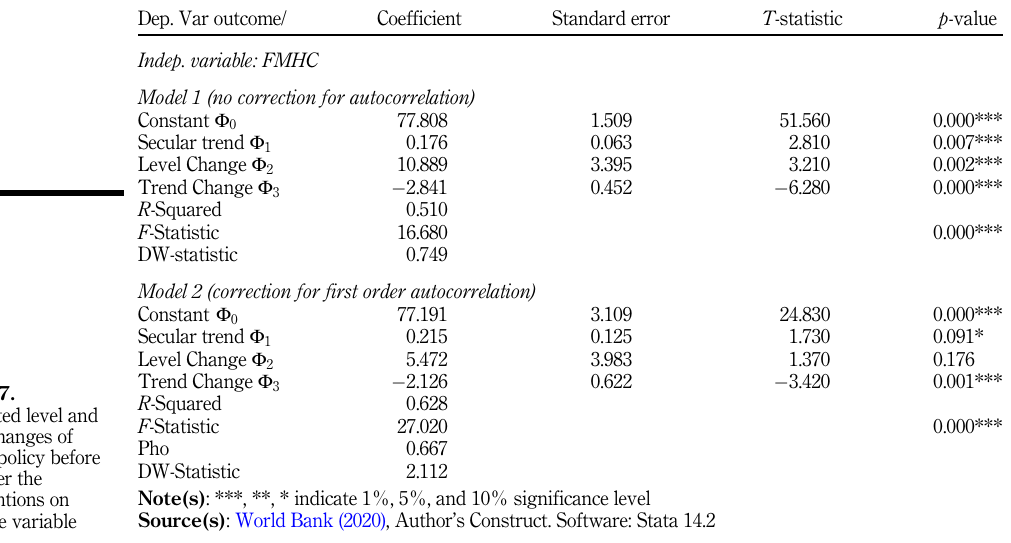
Table 7. Estimated level and trend changes of FMHC policy before and after the interventions on outcome